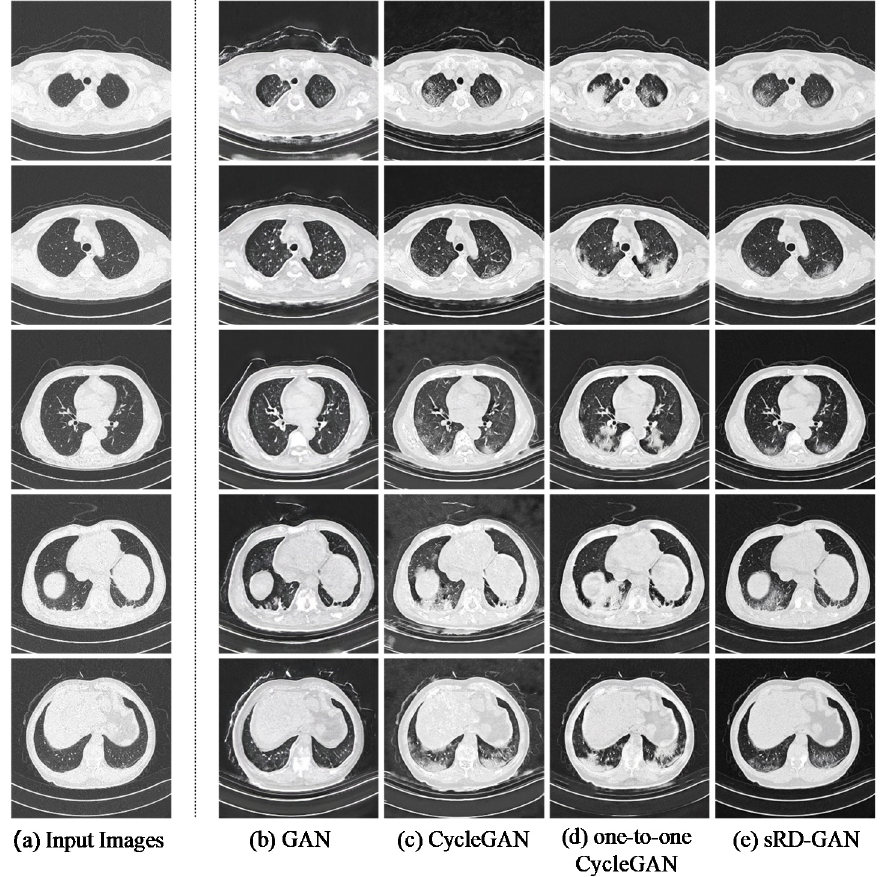
Figure 19. ( a ) Real COVID-19 CT images, ( b – e ) example of synthetic images generated by the proposed sRD-GAN and other GAN baselines. The synthetic images generated from GAN and CycleGAN contain a suboptimal realistic representation of the synthetic instances with large magnitude of noise artifacts.